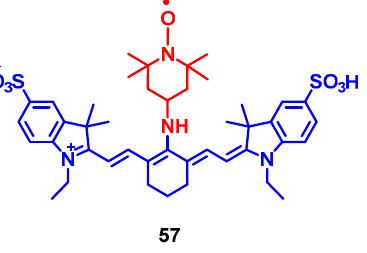
Figure 19. TEMPO-Cy7 dyad 57 as triplet PS for PDT studies.